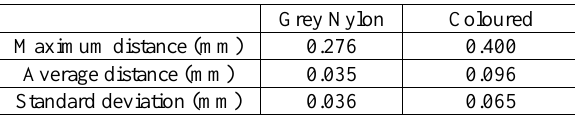
Table 2: Statistical indices obtained from the comparisons of the grey nylon replica and the coloured one